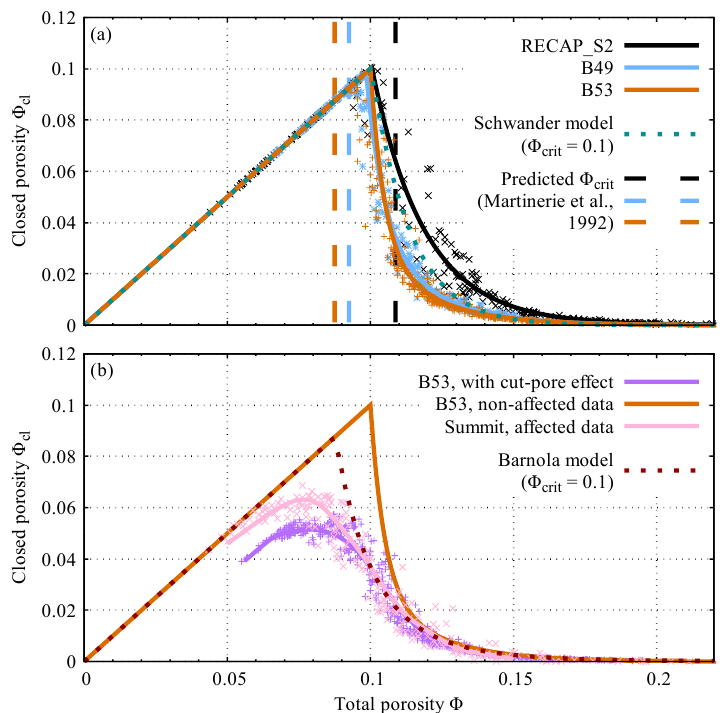
Figure 2. Closed versus total porosity for (a) the analyzed cores in comparison with commonly expected values and (b) B53 ignoring cut pores compared to previous results from Summit, Greenland (Schwander et al., 1993). The solid lines indicate least squares fits for the respective core, the short-dashed lines represent model results (Schwander, 1989; Goujon et al., 2003) for the given parameters, and the long-dashed lines mark the critical porosity values predicted by the previously observed temperature dependence (Martinerie et al.,